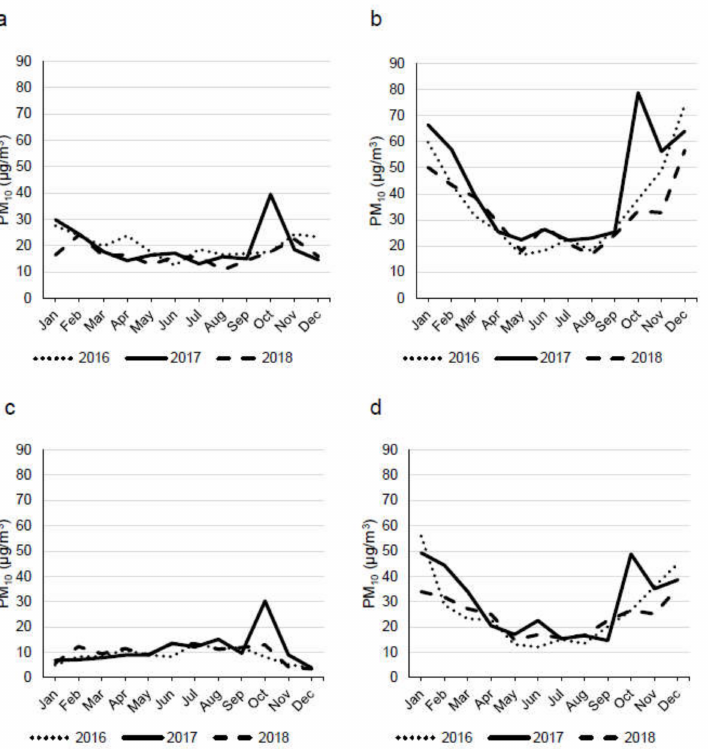
Figure 2. Monthly mean of PM 10 concentrations in the four sampling sites: Chiomonte—site F ( a ), Torino—site T ( b ), Ceresole Reale—site C ( c ), Novara—site N ( d ). Wildland fire period = October